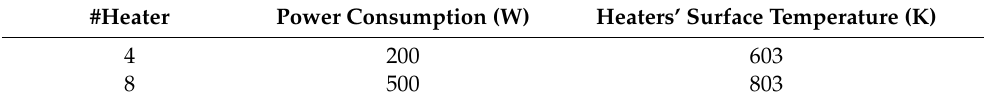
Table 2. Initial condition of heating elements for test.